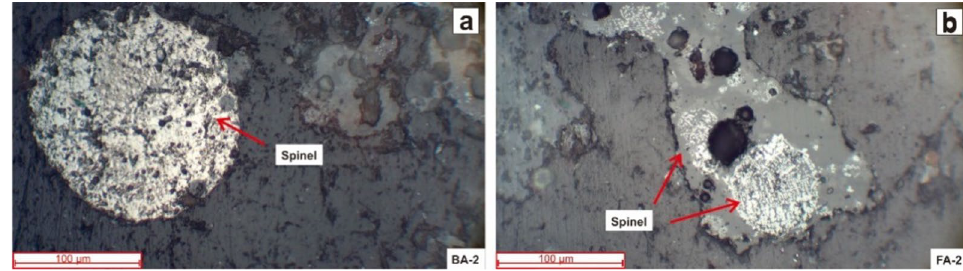
Fig. 8 Spinel; a BA sample; b FA sample. (All photomicrographs are taken under white